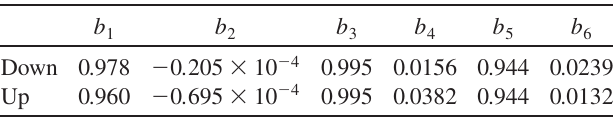
TABLE III. Parameters of the approximation for the electron beam energy.